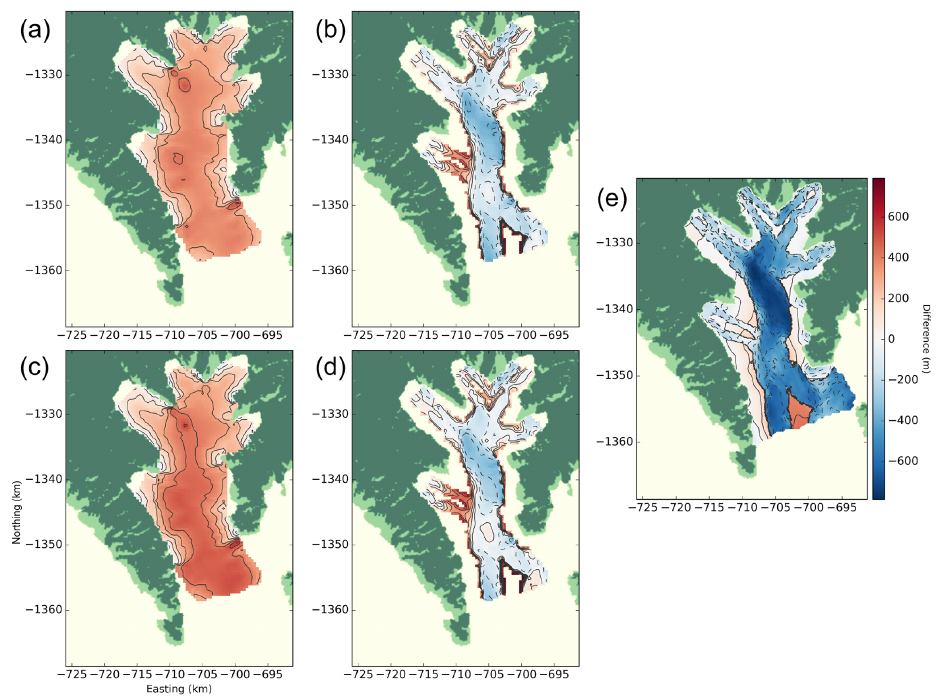
Figure 11. Bed elevation differences displaying (a) Bed2013 minus SynthIBCAO, (b) OBS1516 minus SynthIBCAO, (c) Bed2013 minus SynthOBS, (d) OBS1516 minus SynthOBS and (e) OBS1516 minus Bed2013 within the Cape York area of interest. Positive differences (red) occur where the subtrahend is deeper than the minuend, with negative differences (blue) occurring where the subtrahend is shallower than the